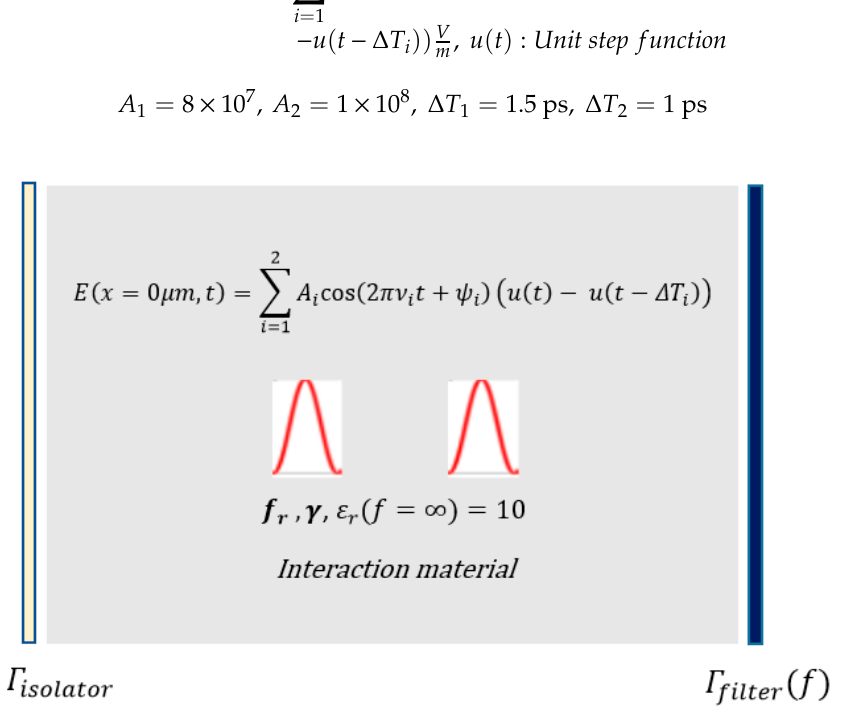
Figure 3. Nonlinear mixing of two ultrashort pulses in an optical microcavity, whose frequencies were tuned for high-intensity targeted harmonic generation at 820THz via intracavity energy maximization.